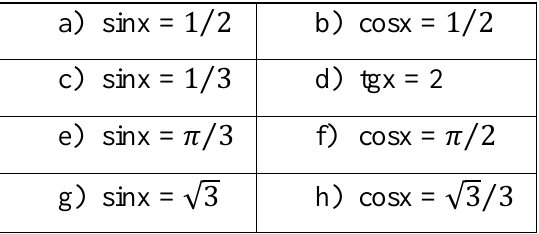
Table 2.1 Experiment in Bagni,